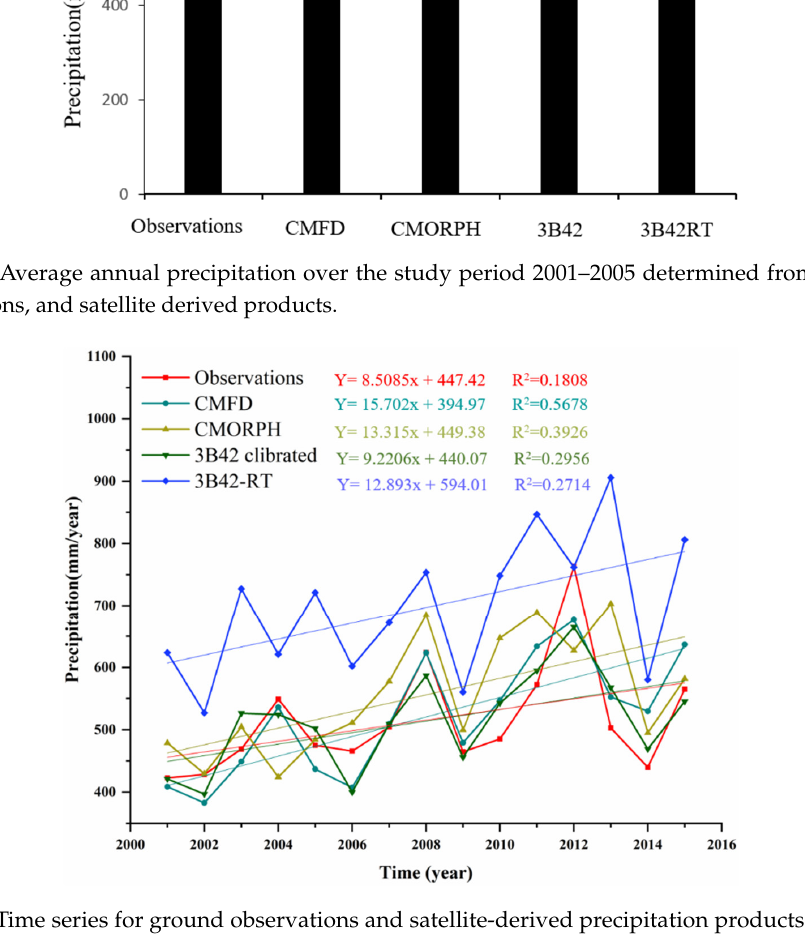
Figure 7. Time series for ground observations and satellite-derived precipitation products showing average annual precipitation for 36 stations in Beijing from 2001 to 2015.